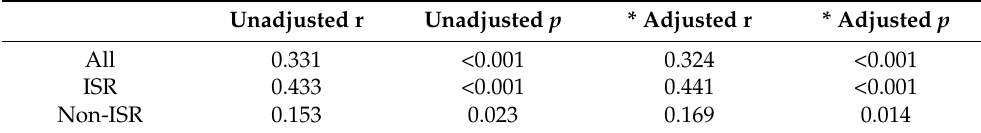
Table 2. Correlation between CML and IgE in patients with T2DM. Unadjusted r Unadjusted p * Adjusted r * Adjusted p All 0.331 <0.001 0.324 <0.001 ISR 0.433 <0.001 0.441 <0.001 Non-ISR 0.153 0.023